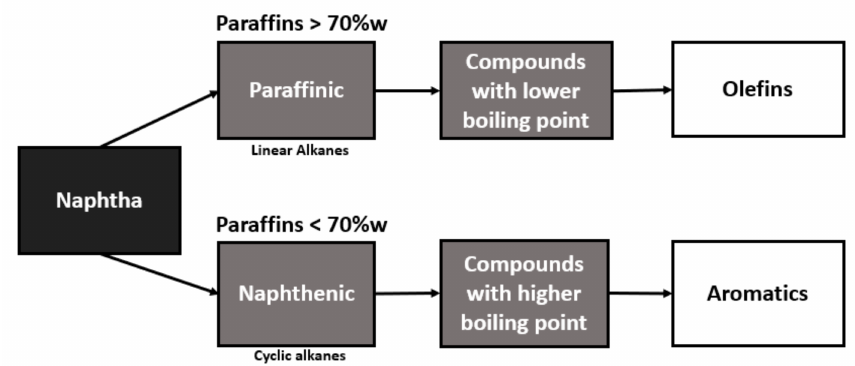
Figure 1. Flowchart of naphtha conversion into basic